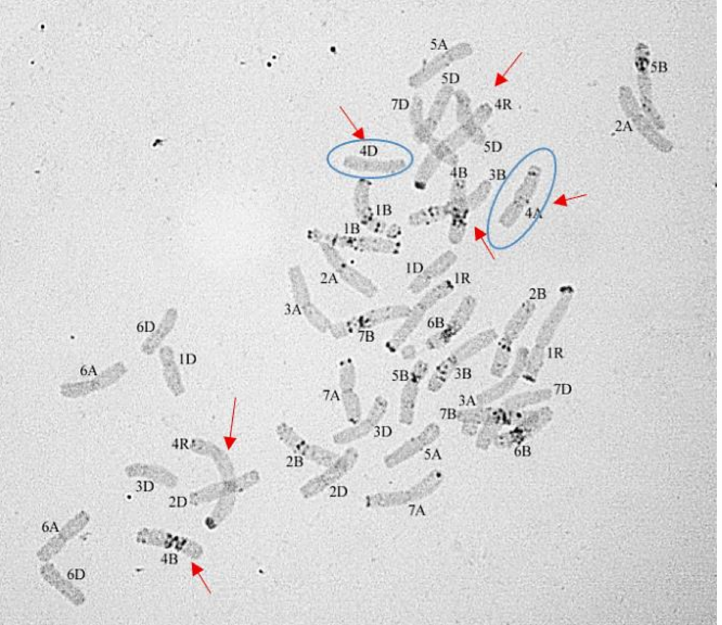
Figure 10. Karyotype with disomic substitution 1R(1A) and monosomic substitutions 4R(4A) and 4R(4D) 2 n = 42.